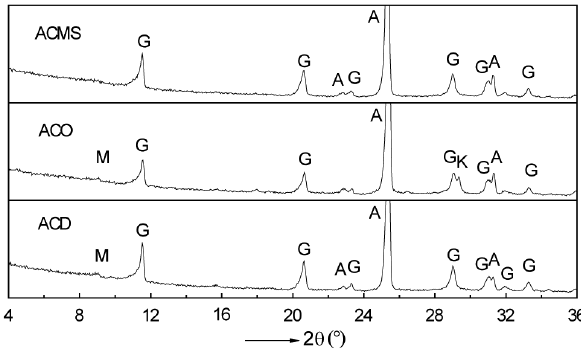
Fig. 4. X-ray diffraction pattern of hardened (for 7 months) ACP pastes: G – gypsum; A – anhydrite; M – calcium mono- sulphoaluminate; K – calcite